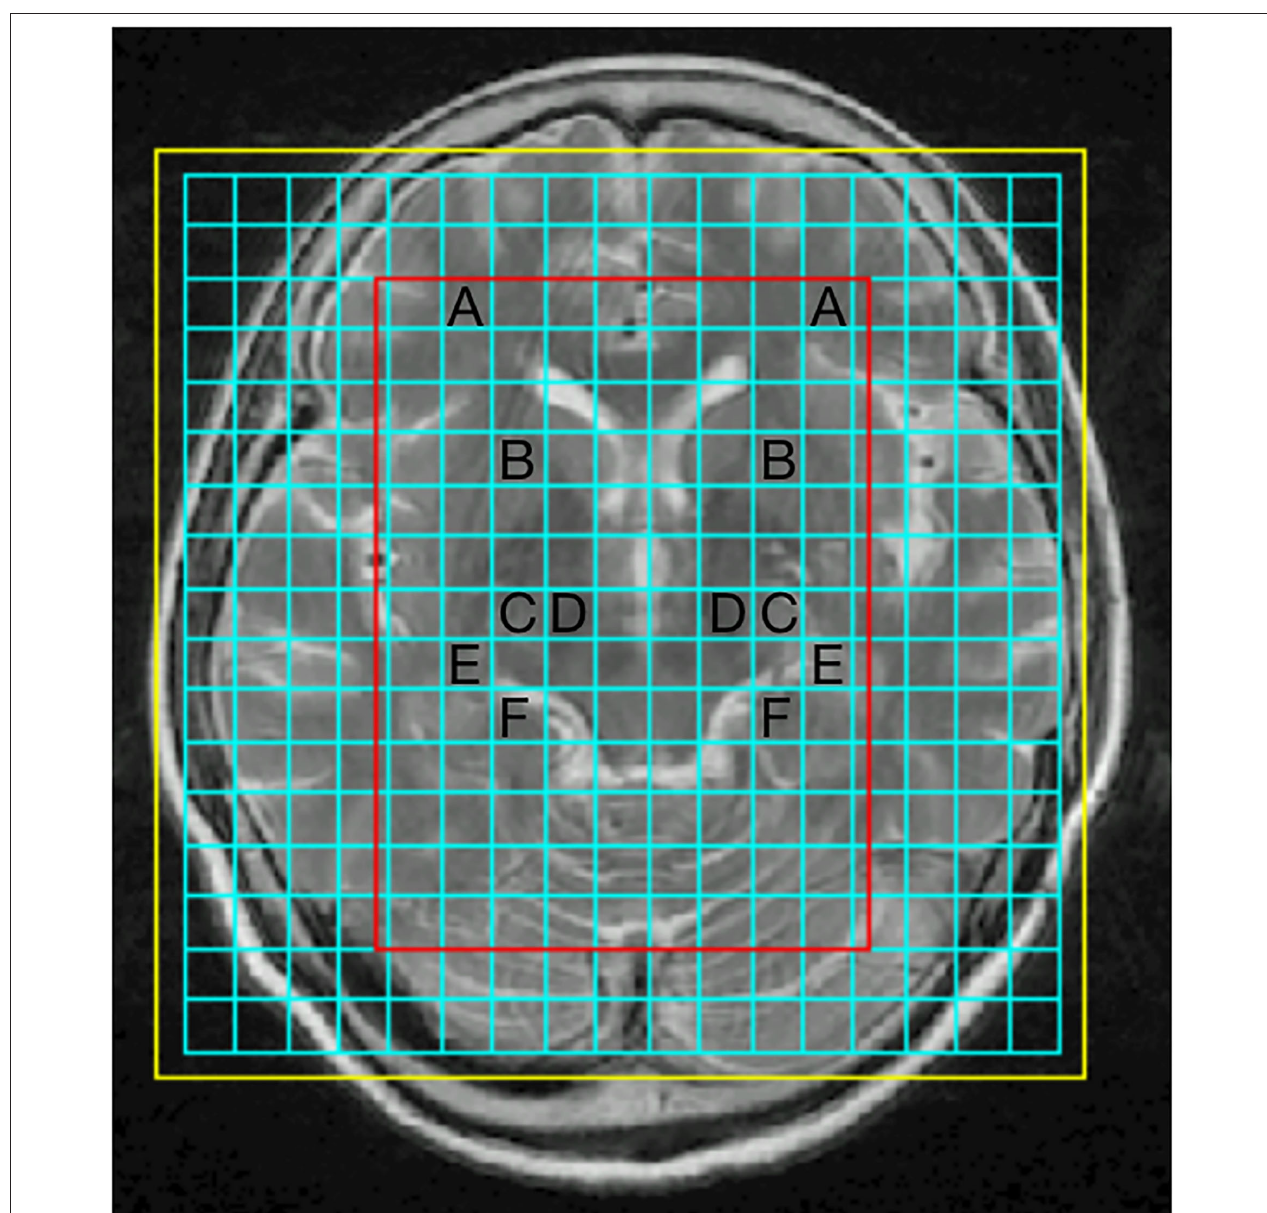
FIGURE 1 | Representative proton magnetic resonance spectroscopy ( 1 H-MRS) spectra for four brain regions: prefrontal cortex (A) , pallidum (B) , thalamus (C) , substantia nigra (D) , hippocampus (E) , parahippocampal gyrus (F) .